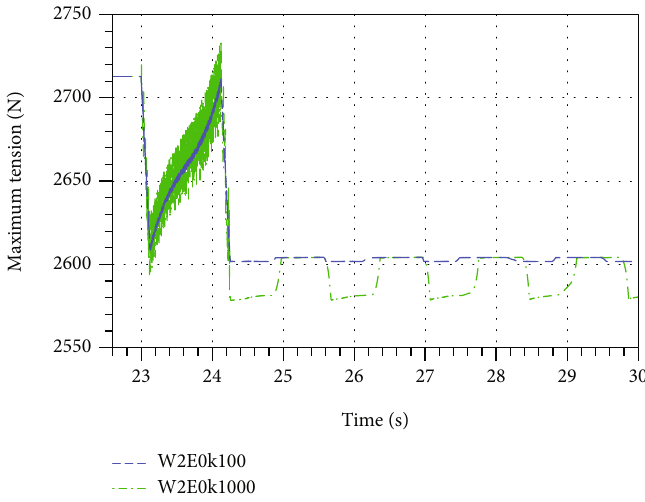
Figure 10: Case W2E0-k tension histories with di ff erent k .